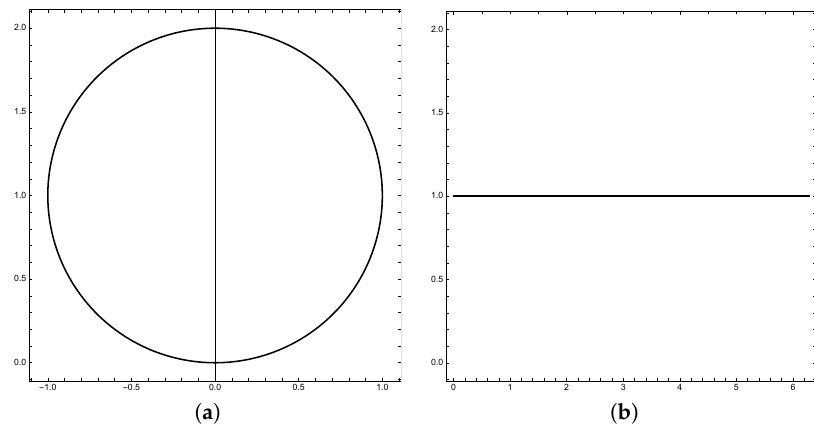
Figure 1. ( a ) Curve with ρ ( θ ) = U ( 0,1, θ ) , 0 ≤ θ ≤ 2 π , ( b ) curvature.